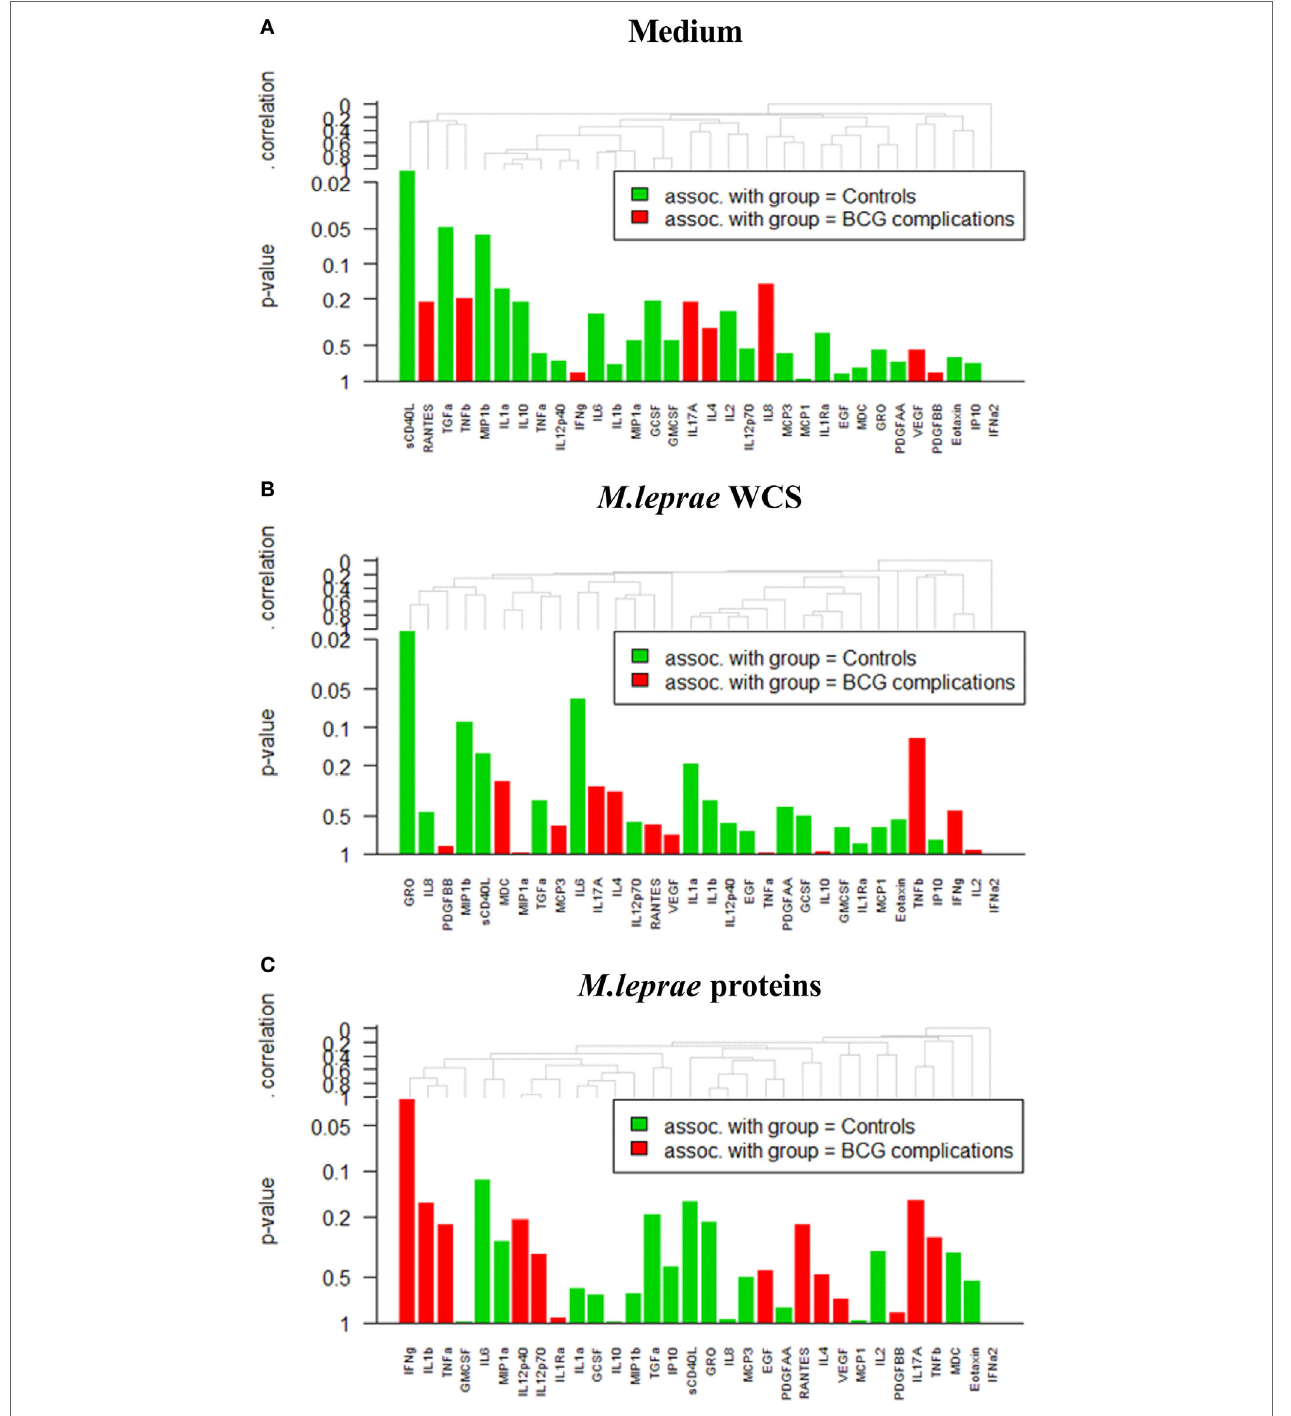
FiGUrE 4 | Results of whole-blood assays (WBAs) in contacts with and without BCG complications in (a) medium (designated NIL). (B) Mycobacterium leprae whole cell sonicate (designated WCS). (C) ML2478/ML0840 recombinant proteins (designated Mlep) (C)